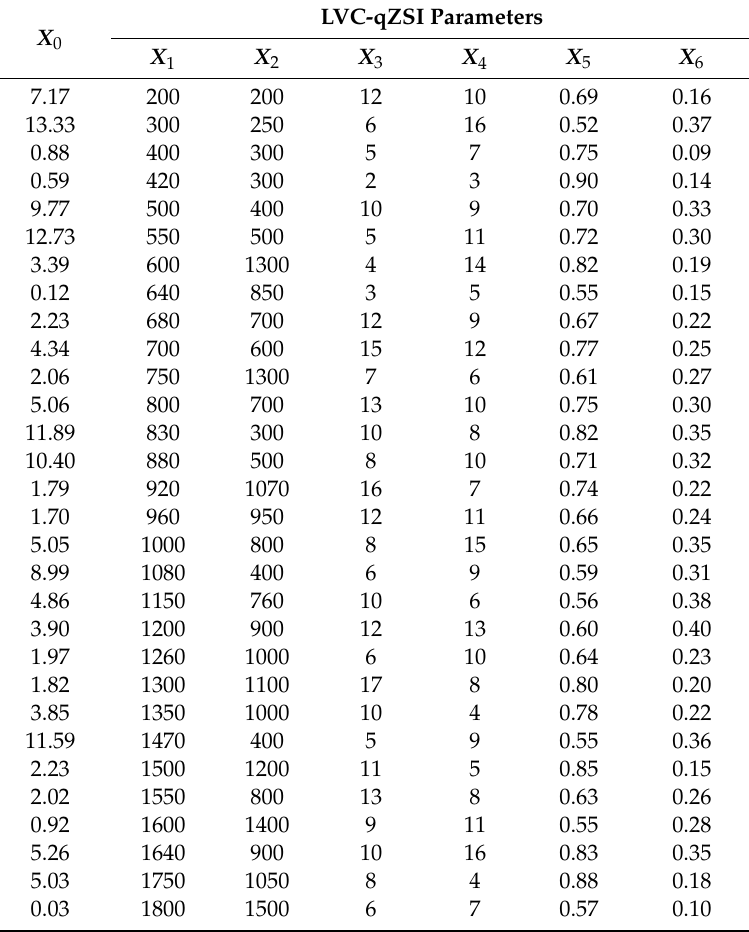
Table 2. Values of LVC-qZSI